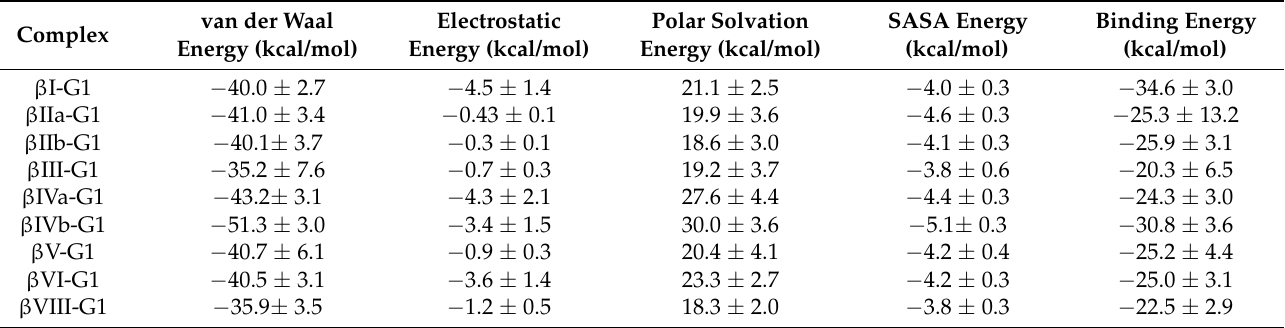
Table 6. Averaged binding free energies of the simulated β -tubulin–G1 complexes from MM-PBSA estimation during the last 30